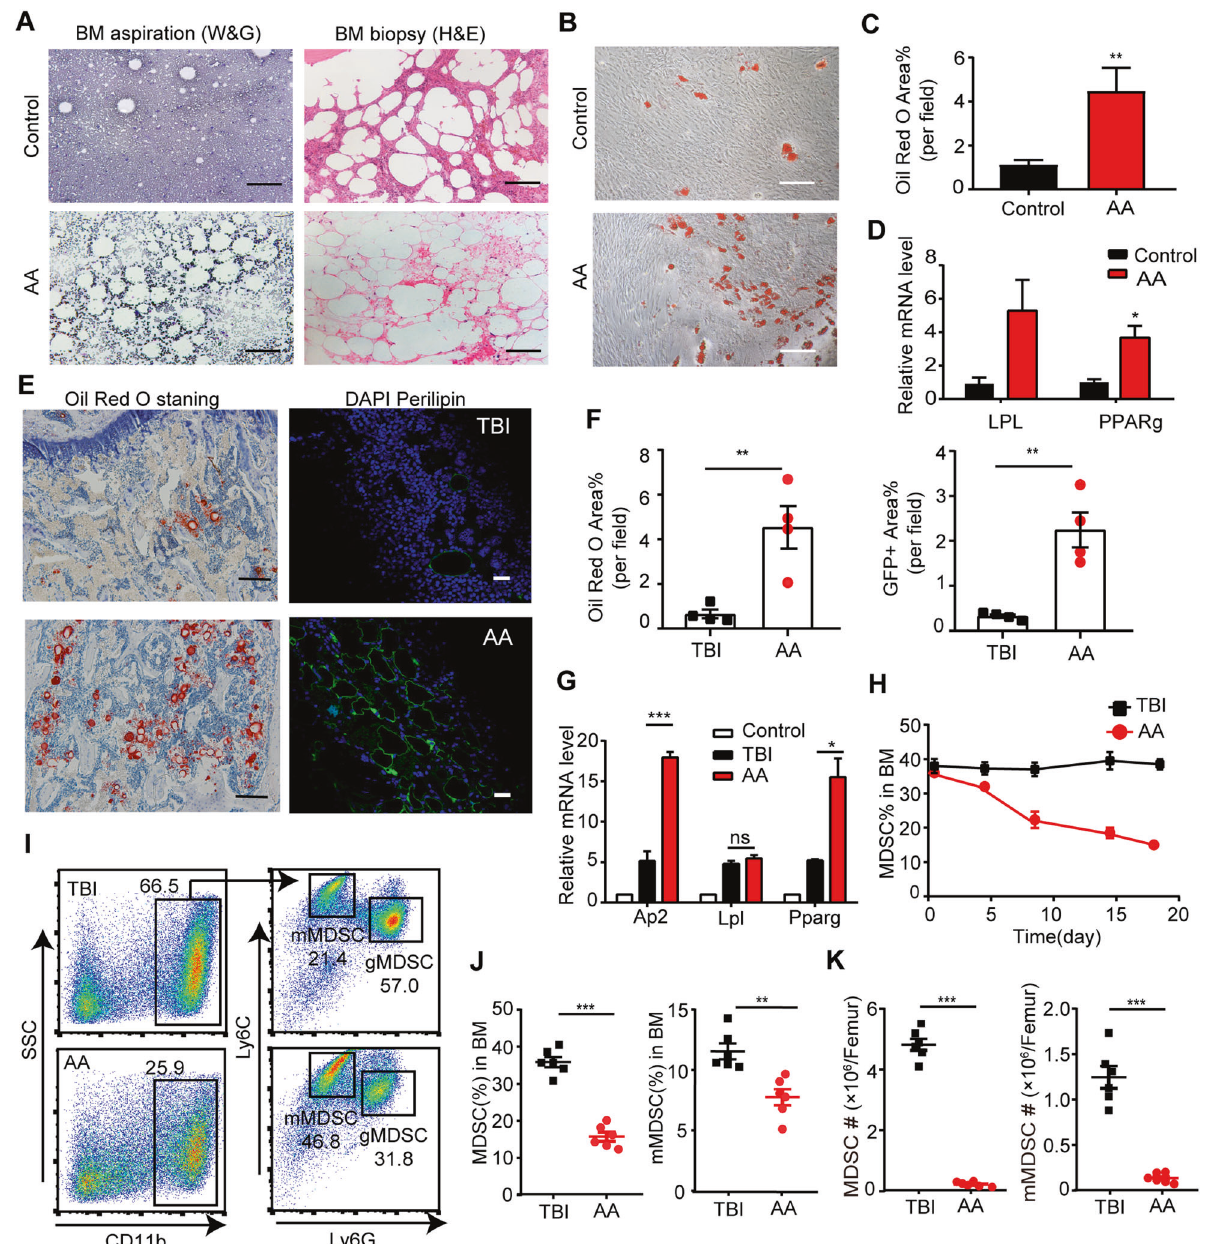
Fig. 1 The polarized adipogenic differentiation of BM-MSCs and decreased MDSC populations in AA mice. A Representative Wright- Giemsa staining of BM aspiration (left panel) and H&E staining of BM biopsy (right panel) from AA patients and controls. Scale bar:100 μ m. B Images of representative Oil Red O staining of adipogenic induced BM-MSCs from AA patients and controls. Scale bar:200 μ m. C Percentage of the area showing Oil Red O staining cells per fi eld in the BM image of AA patients and controls on day14 of MSCs ’ adipogenic differentiation. Data were presented as the mean ± SD. N = 6 in each group. Independent experiments were repeated three times. *** P < 0.01. D Quantitative RT-PCR analysis of adipogenic markers ( LPL, PPARg ) in BM-MSCs of AA patients and controls. Data represent mean ± SEM in three independent experiments. N = 6 in each group. * P < 0.05. E Oil Red O staining and fl uorescent staining of perilipin (green) and DAPI (blue) were performed on femur bone section from AA mice and TBI mice. Scale bar:50 μ m. F Percentage of the area showing Oil Red O staining cells (left) and GFP + Perilipin staining ( right) per fi eld in the BM image of TBI mice and AA mice on day14 of MSCs ’ adipogenic differentiation. Data were presented as the mean ± SD. N = 4 in each group. ** P < 0.01. G Relative expression of Ap2, Lpl , and Pparg in BM from AA and TBI mice were determined. Data represent mean ± SEM in three independent experiments. N = 6 in each group. * P < 0.05, *** P < 0.001. H The percentage of MDSCs in BM of TBI mice and AA mice were detected after irradiation and LN cell injection. Data were presented as the mean ± SD. N = 3 in each group at each time point. I Representative immunophenotypic analysis of BM MDSCs, mMDSCs, and gMDSCs in TBI and AA mice on day 14. The percentage ( J ) and ANs ( K ) of MDSCs, and mMDSCs in BM were determined from AA and TBI mice. Data were presented as the mean ± SD. N = 6 in each group. ** P < 0.01,*** P < 0.001.